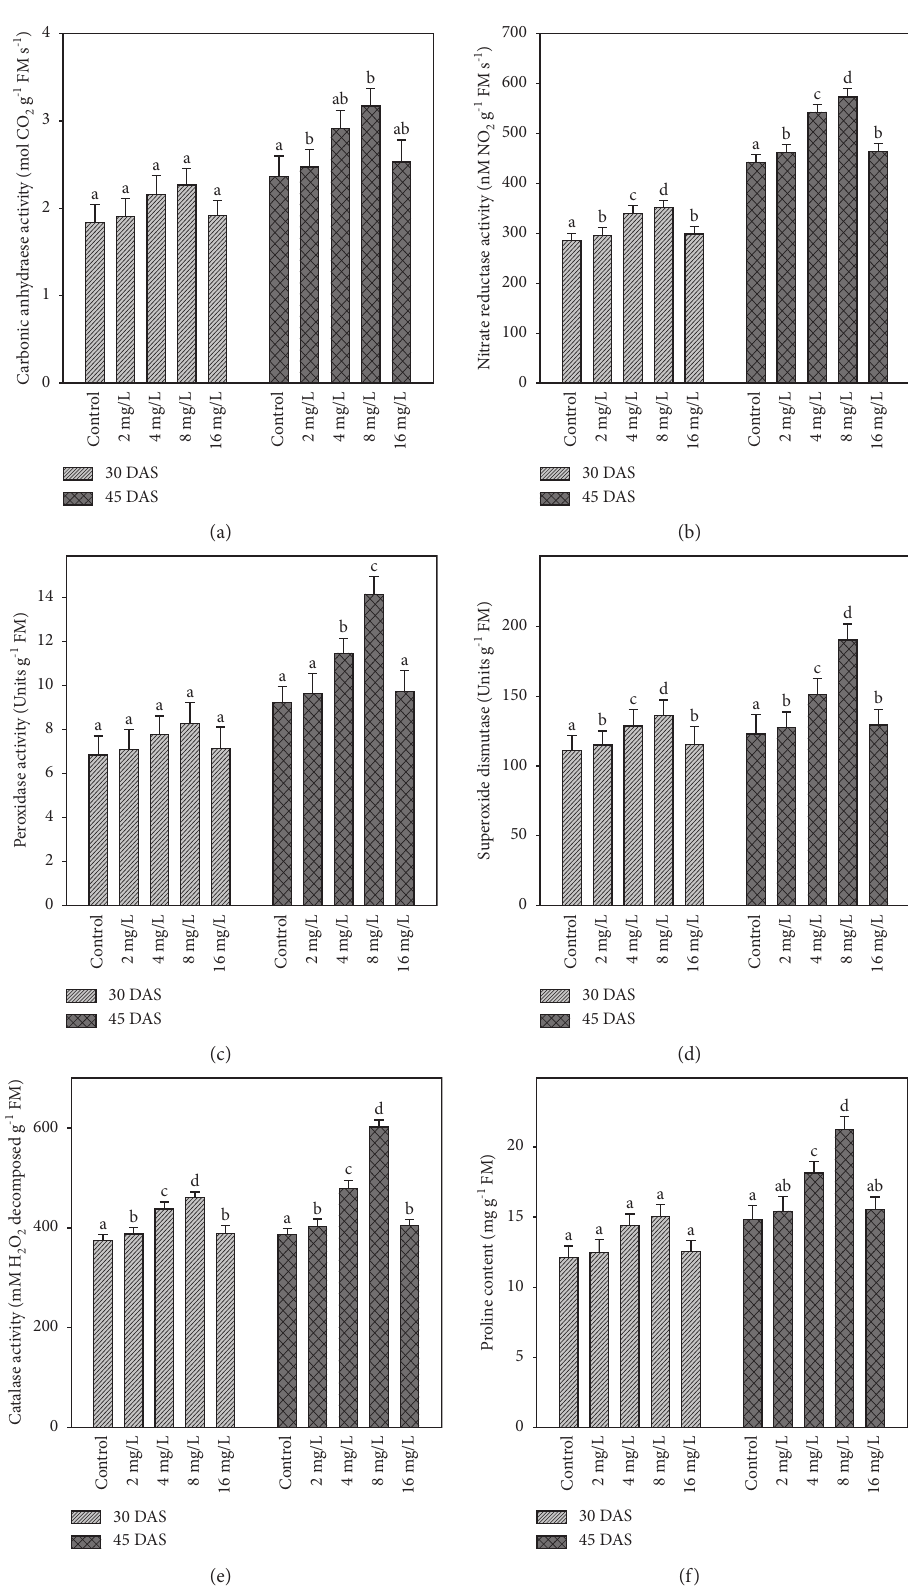
Figure 3: Effect of nanoparticles (NPs) on the (a) carbonic anhydrase activity, (b) nitrate reductase activity, (c) peroxidase activity, (d) superoxide dismutase, (e) catalase activity, and (f) proline of mustard at 30 and 45 DAS. All the data are the mean of five replicates ( n � 5), and vertical bars shows standard errors ( ± SE). (Different alphabet represents the significant difference ( p < 0 . 05) of treatments compared to the control